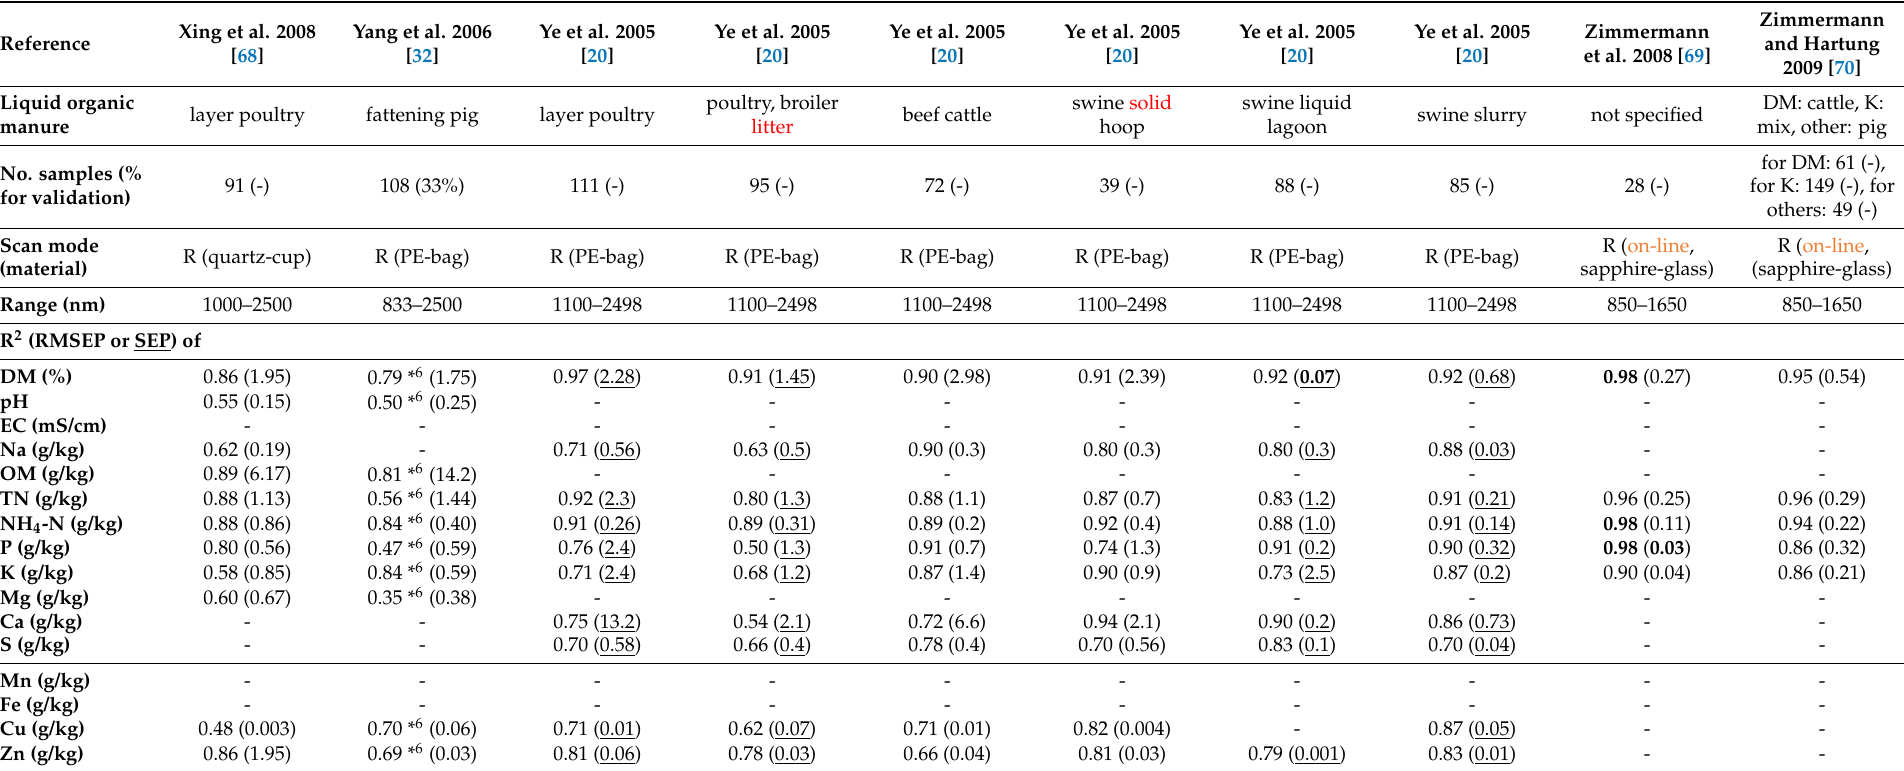
Best values for each parameter are highlighted in bold letters, dried samples in red, on-line technique in orange, and SEP values in underlined letters. Scan mode: R = reflectance; Parameters: DM = dry matter, EC = electrical conductivity, OM = organic matter, TN= total nitrogen; R 2 = coefficient of determination, RMSEP = root mean squared error of